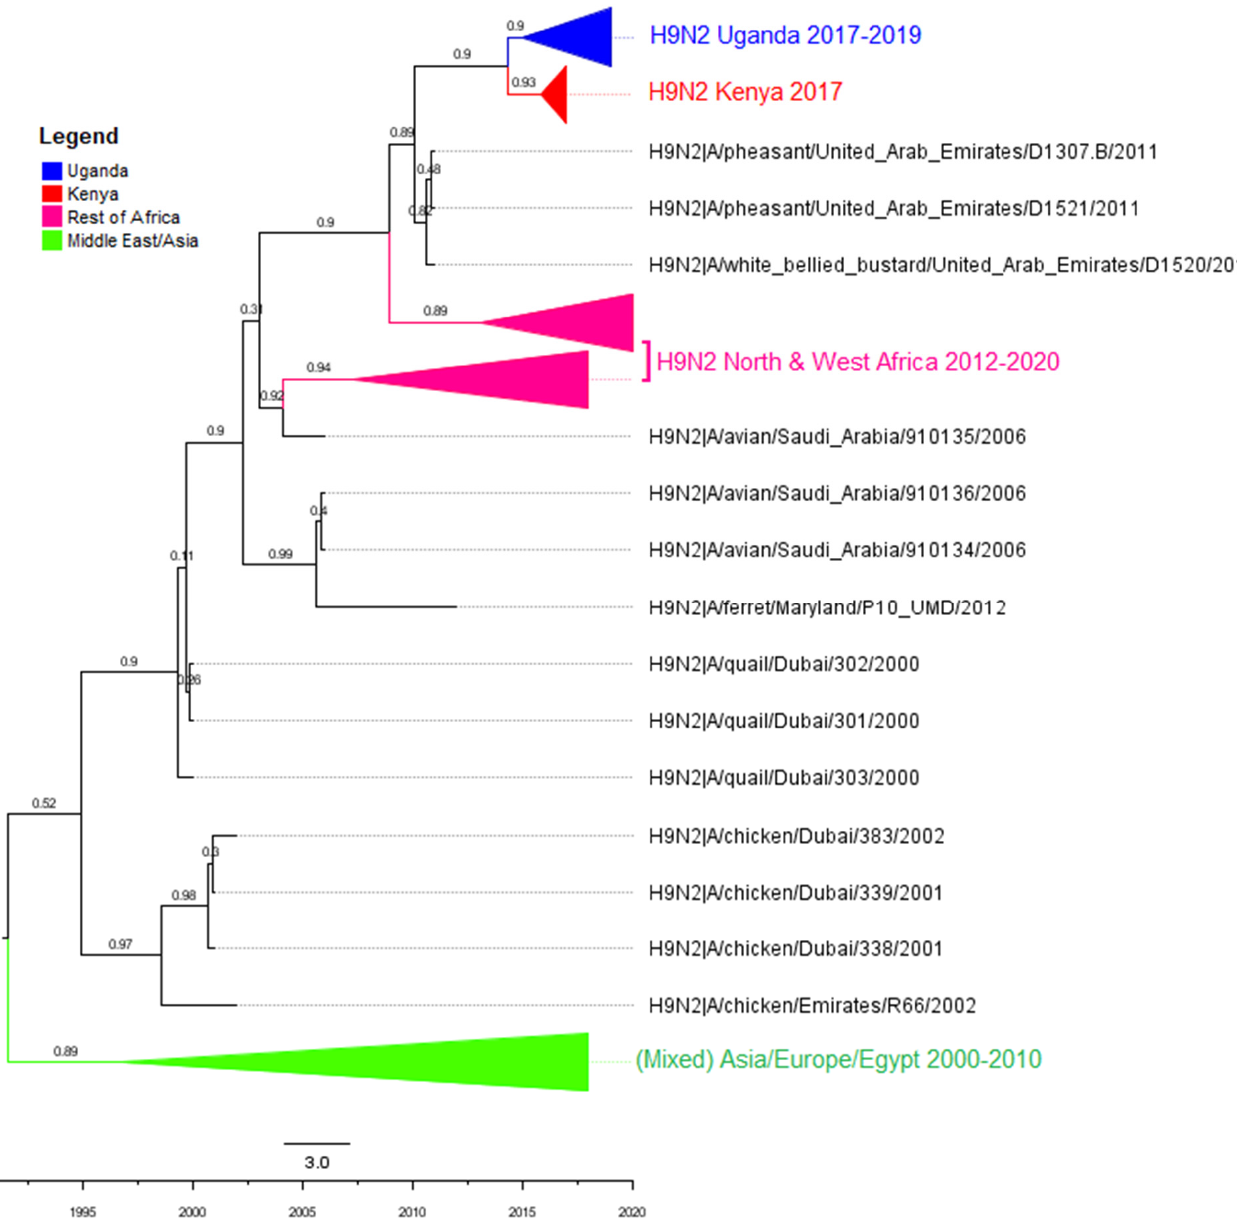
Figure A7. Phylogenetic tree for NS. Ugandan viruses are highlighted in blue, Kenyan in red, North and West African countries in pink, and the Middle East and Asia in the green clade. tMRCA for Uganda is May 2014.Posterior probabilities are shown on the branches. Scales represent substitutions and time.